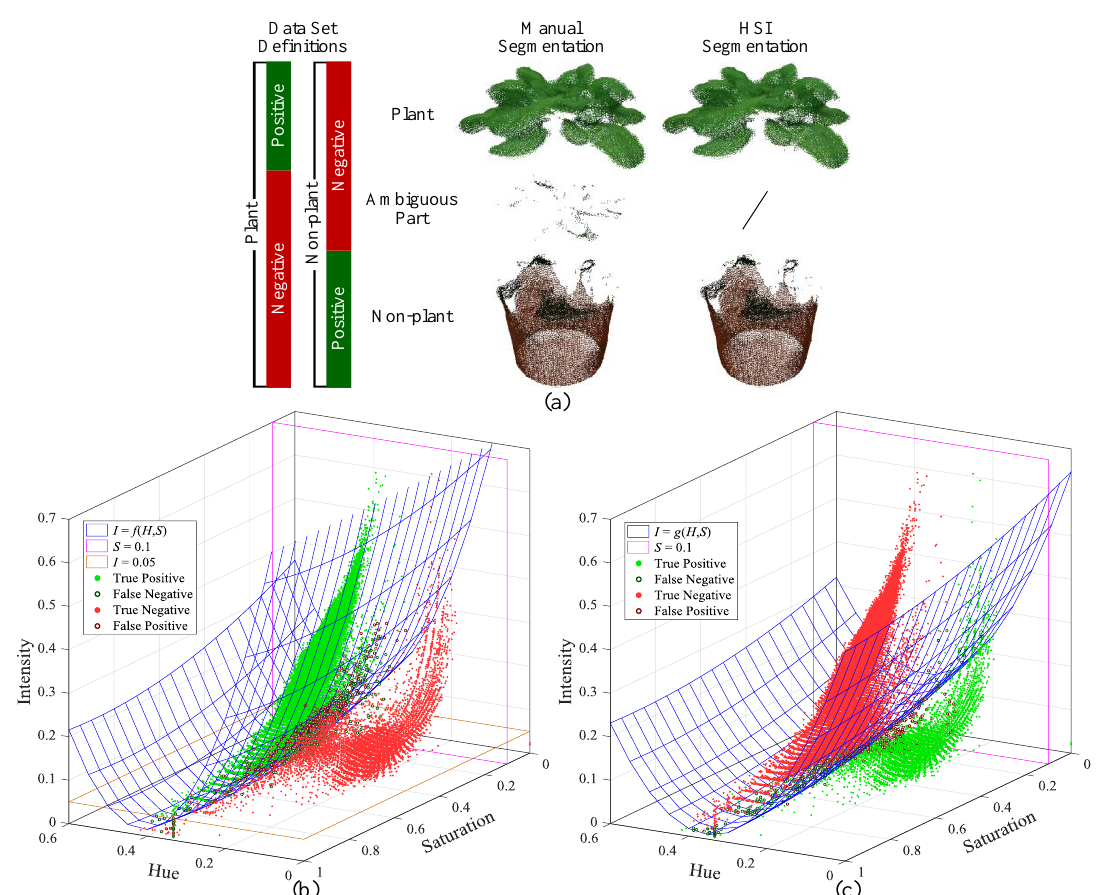
Figure 4. Plant and non-plant segmentation based on HSI color space: ( a ) data set definitions and segmentation results; ( b ) plant segmentation model; and ( c ) non-plant segmentation model. The data points in ( b , c ) are from the training set (combined by the data of three different sized plants). The interactive 3D scatter plots of ( b , c ) can be found in Supplementary Material B.